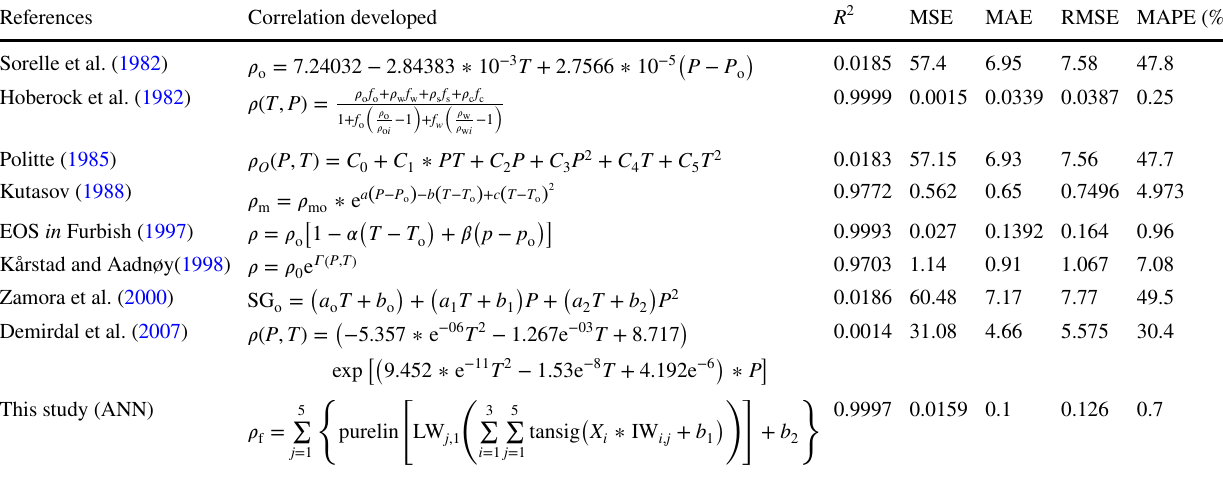
Table 11 Generalization capacity assessment of various models used for predicting downhole density of oil-based muds